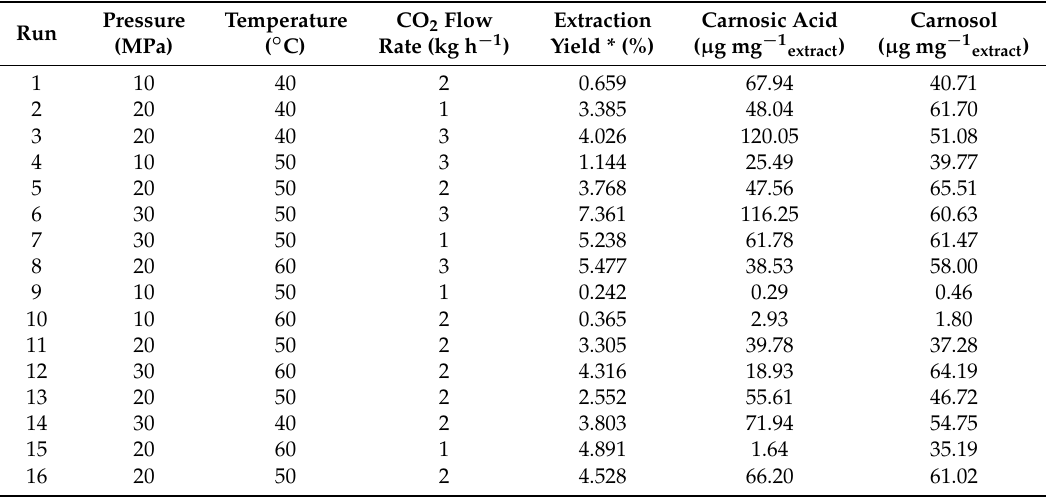
Table 2. Experimental matrix and values of observed